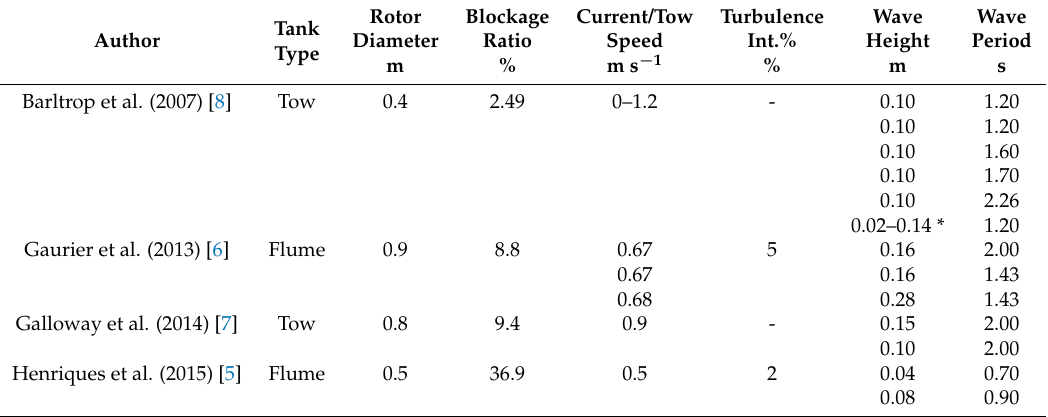
Table 1. Summary of experiments undertaken for wave-curreny interactions with three-blade HATTs. Rotor Blockage Current/Tow Turbulence Wave Wave Tank Diameter Ratio Speed Int.% Height Period Author Type m % m s − 1 % m s Barltrop et al. (2007) [8] Tow 0.4 2.49 0–1.2